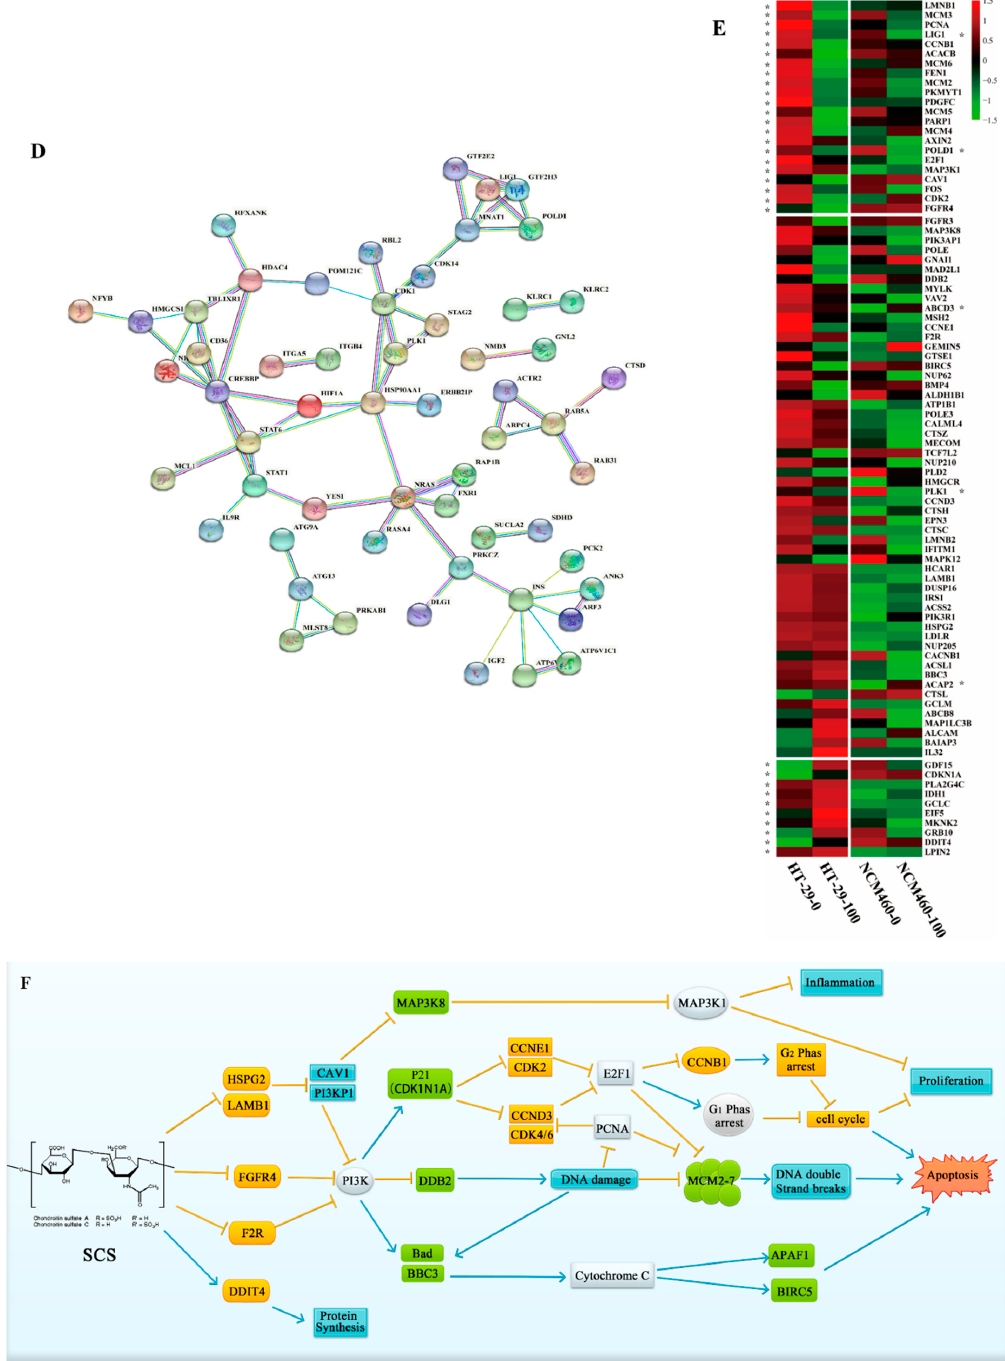
Figure 3. Comparative and integrative analyses of the two RNA-seq datasets from SCS-treated HT-29 cells and NCM460 cells. ( A ) The analyses of the genes with reversely changed expression by the KEGG enrichment analyses in HT-29 cells; ( B ) The analyses of the genes with reversely changed expression by the KEGG enrichment analyses in NCM460 cells; ( C ) The gene-gene interaction network in response in HT-29 cells treated with SCS; ( D ) The gene-gene interaction network in response in NCM460 cells treated with SCS; ( E ) Heat maps show that displayed altered expression of genes in HT-29 cells and NCM460 cells after SCS treatment. Among the 88 genes related to cell cycle and apoptosis pathway, 32 genes in HT-29 cells were significantly different after SCS treatment (fold change > 1.5, p -value < 0.05), while only 5 genes in NCM460 were significantly different, * indicates p -value < 0.05; ( F ) Regulatory network of SCS inhibiting the development of colorectal cancer was